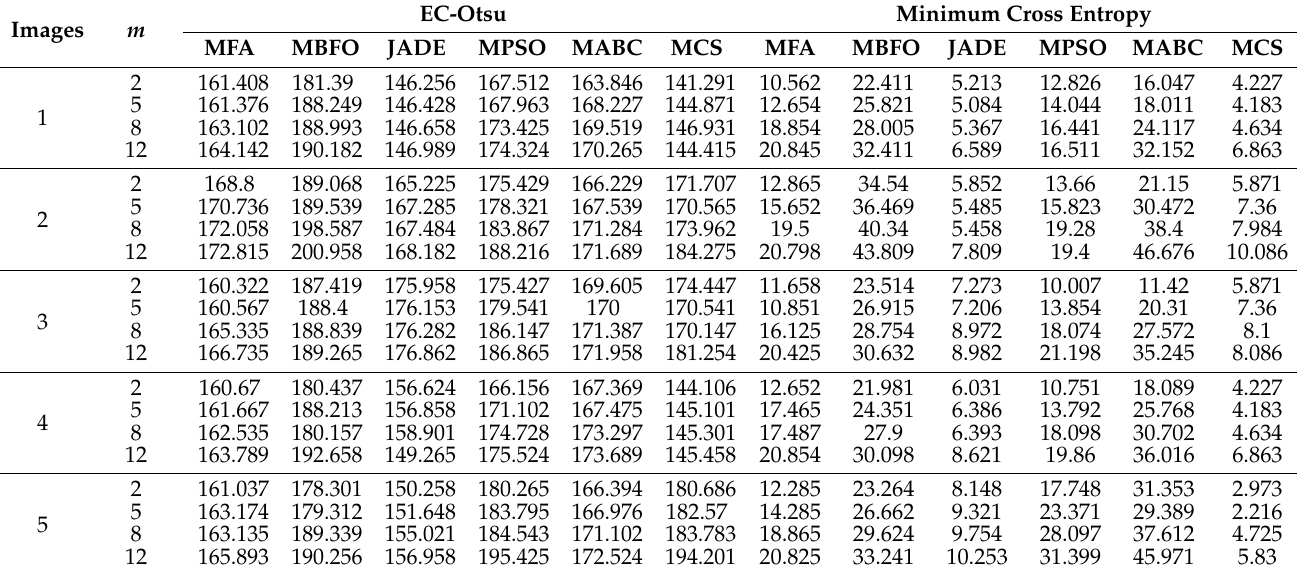
Table A1. CPU time using different optimization algorithms with the EC-Otsu and MCE entropy methods. Images